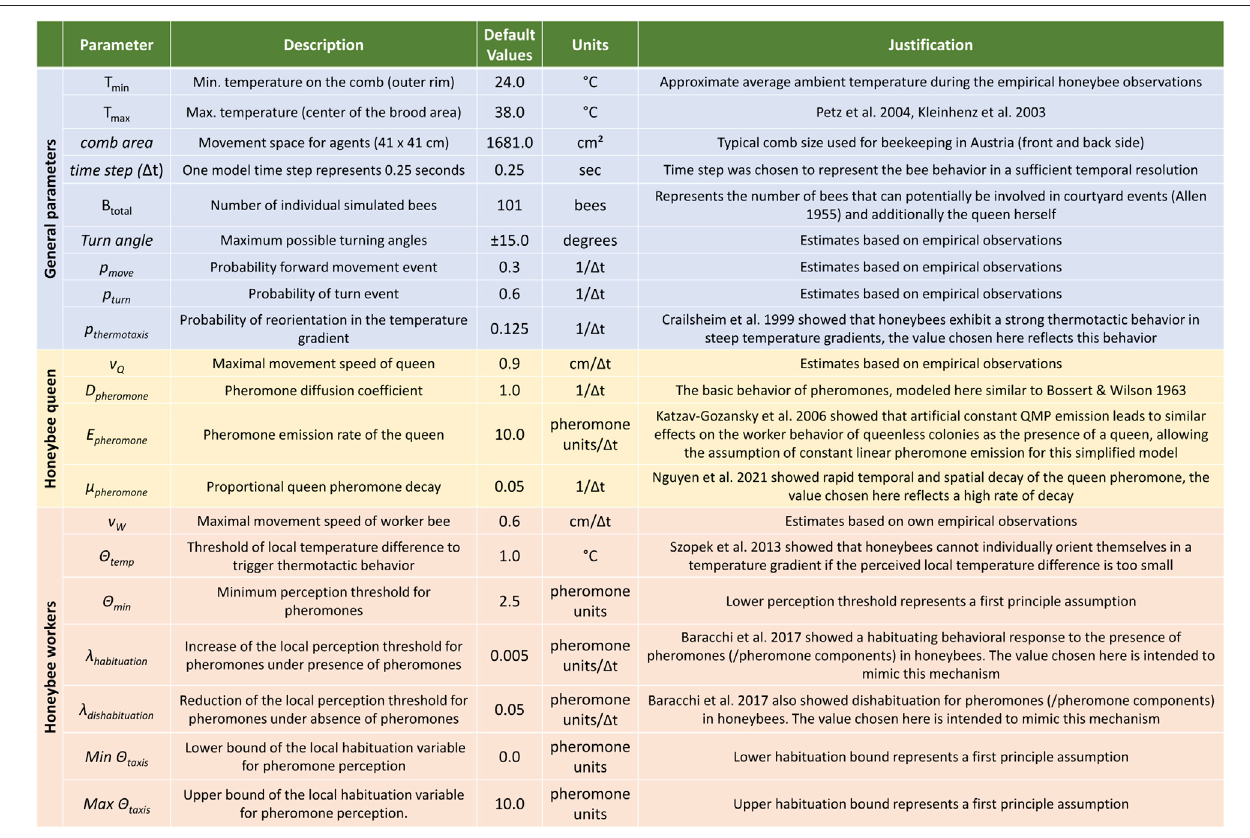
FIGURE 3 | Summary table of model parameters. Parameters could be derived (either quantitatively or qualitatively) from other research publications (Allen. 1955; Bossert and Wilson, 1963; Crailsheim et al., 1999; Kleinhenz et al., 2003; Petz et al., 2004; Katzav-Gozansky et al., 2006; Szopek et al., 2013; Baracchi et al., 2017; Nguyen et al., 2021), collected via empirical observations, or originate from fi rst principle